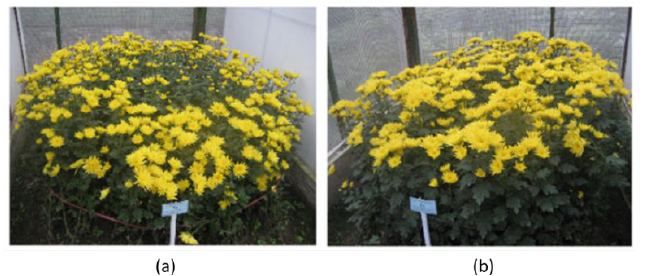
Figure 16. Chrysanthemums under controlled flowering ( a ) By LED with a parabolic reflector. ( b ) By LED with our optical component.